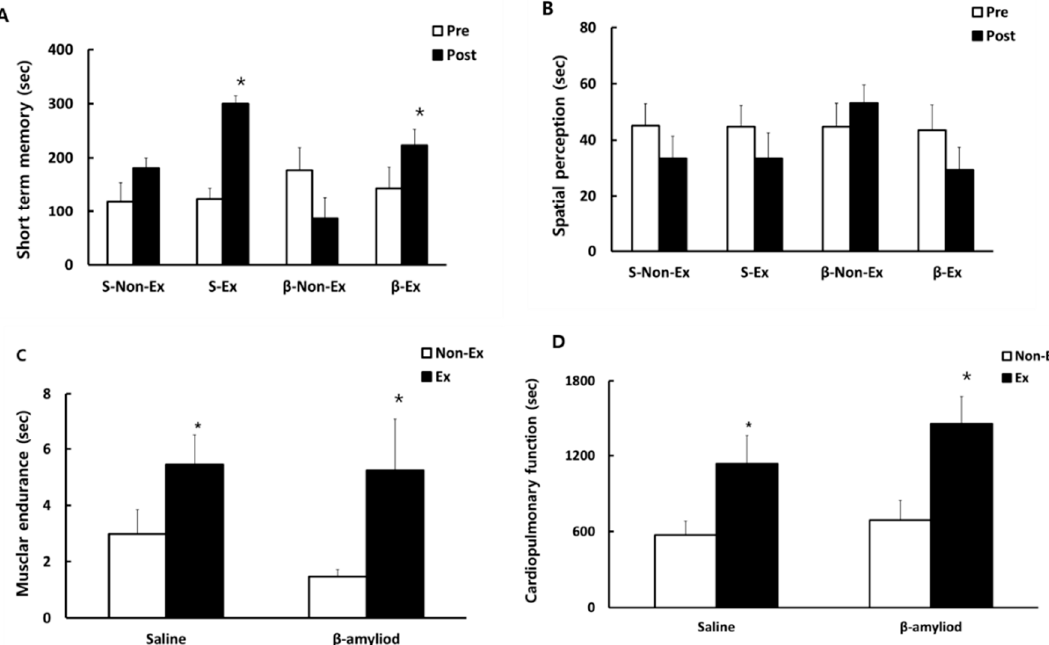
Figure 4. Scores of short-term memory ( A ) and spatial perception ( B ) before and after the 12-week intervention, and the comparison of muscular endurance ( C ) and cardiopulmonary function ( D